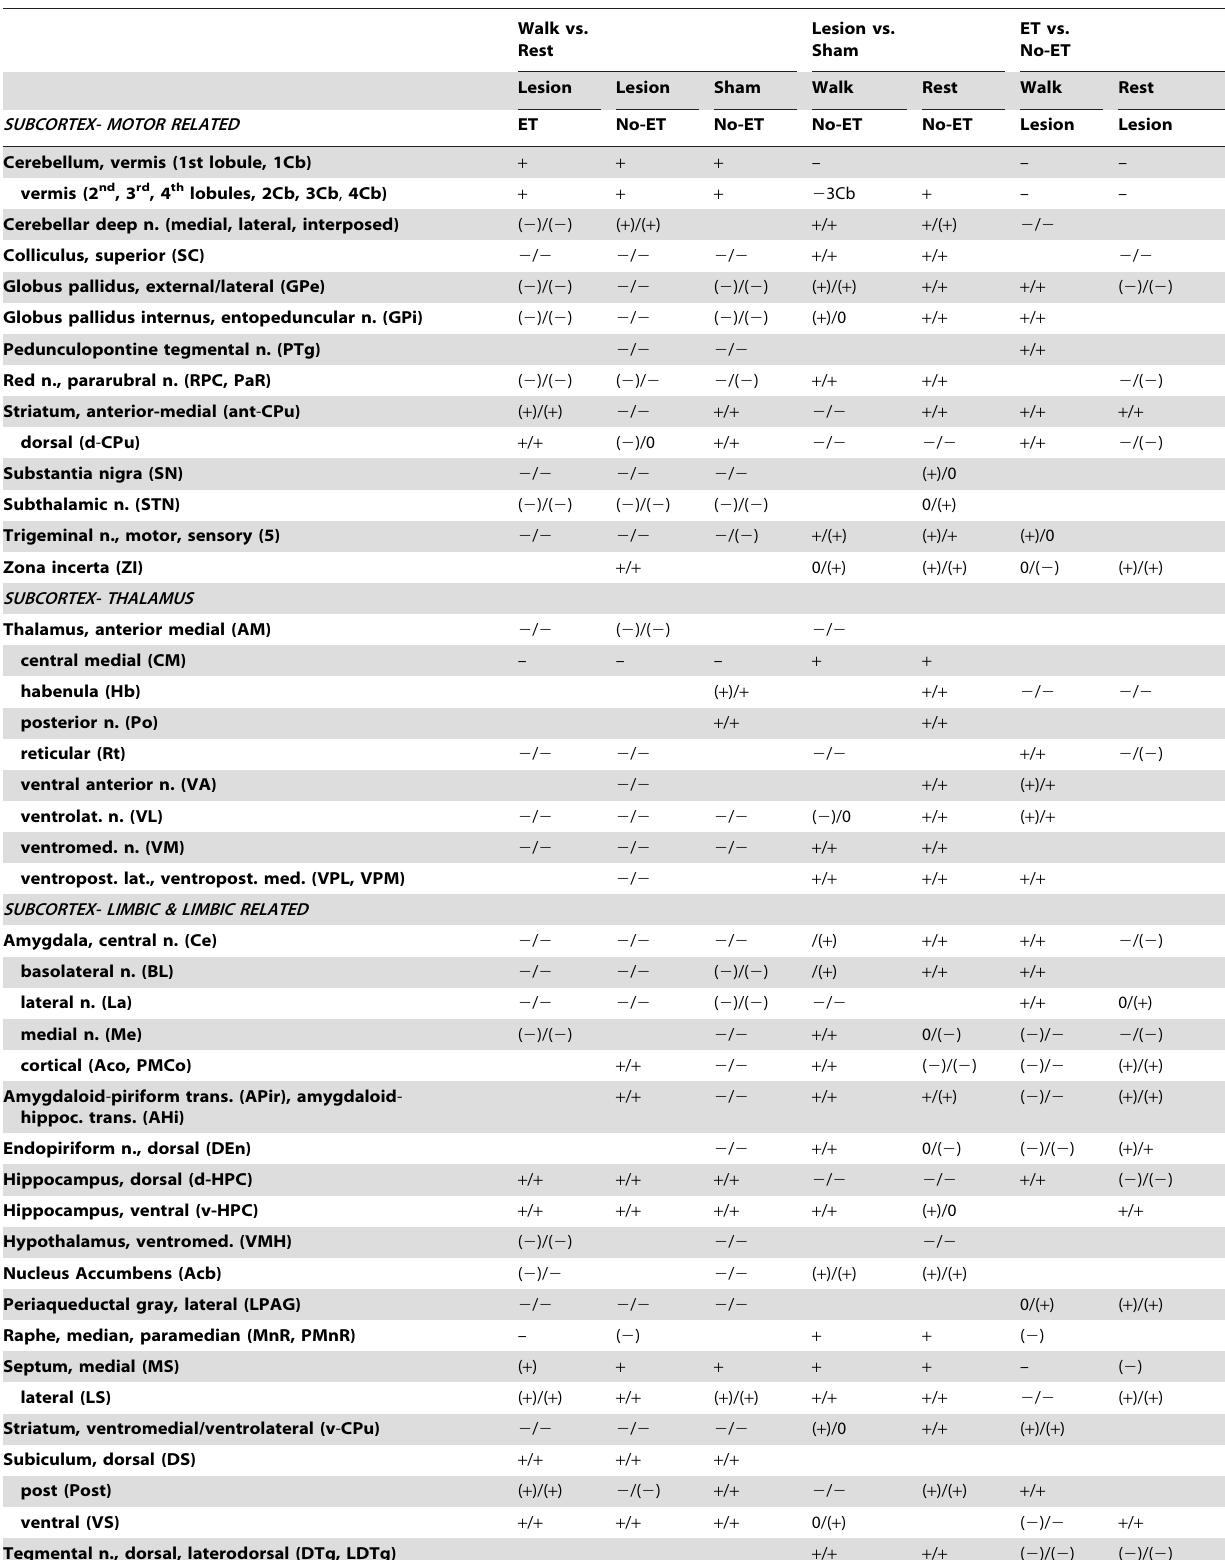
Table 2. Regions of statistically significant differences of functional subcortical activation as determined by SPM analysis.